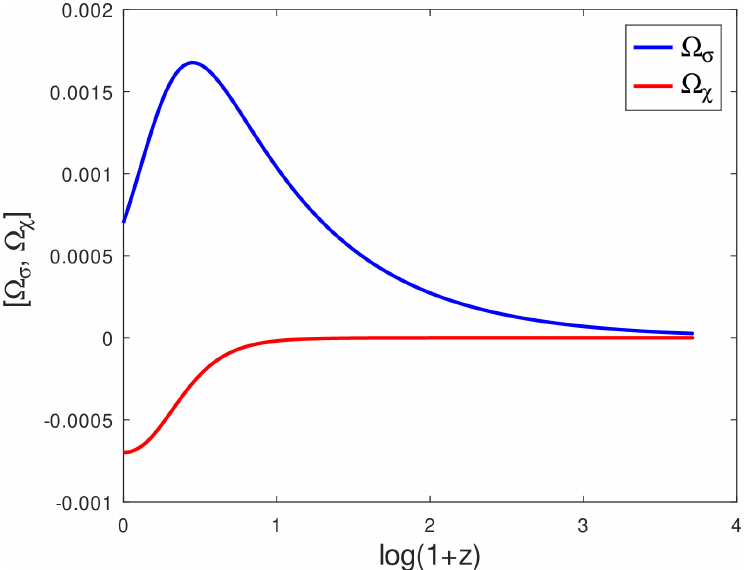
Figure 3. The variation of Ω σ and Ω χ for viscous Bianchi type-V cosmological model vs.